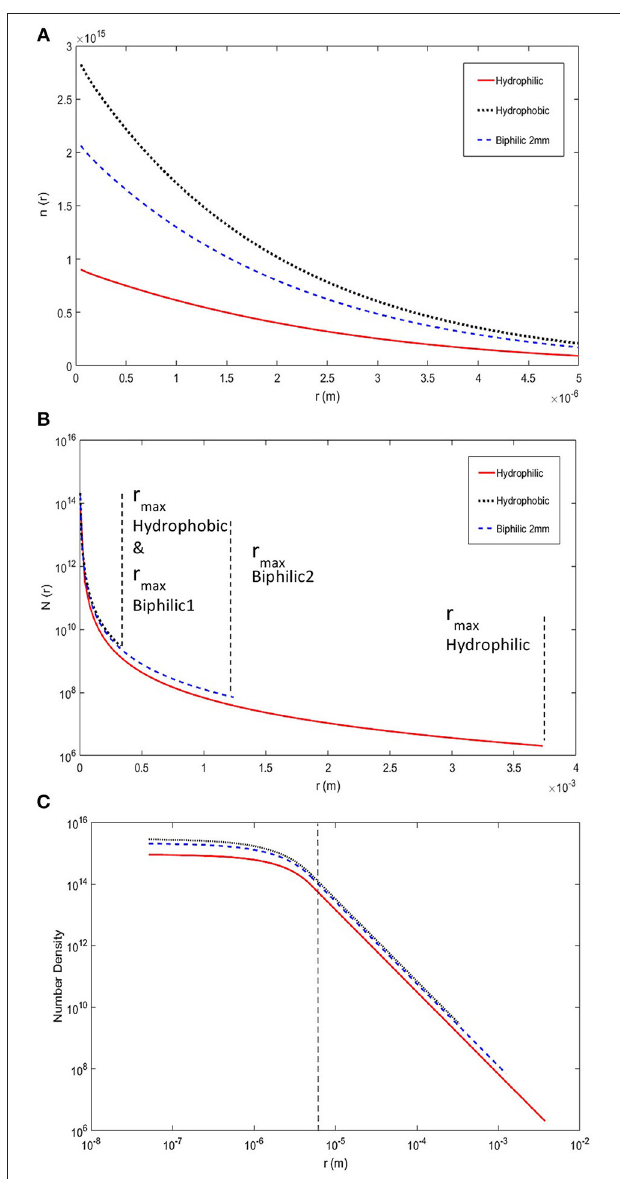
FIGURE 3 | Droplet size distribution as a function of droplet radius for hydrophilic, hydrophobic, and 2mm biphilic substrates. (A) The number densities are shown for small droplets formed by direct condensation. (B) The number densities are shown for large droplets formed by coalescence. The fall-off radii are shown for each substrate. The biphilic surface has two separate fall-off radii corresponding to the hydrophobic sites and hydrophilic base marked as biphilic1 and biphilic2, respectively. (C) The log-log graph of combined number densities for all droplets from initial nucleation to fall-off. The dashed line shows the borderline between small droplets and large droplets. The associated model parameters are: T sat 20 ◦ C, T w 10 ◦ C, δ coat = = − = 1 µ m, k coat 0.15 W/m.K, γ 2mm, hydrophobic θ a and θ r are 150 ◦ and = = 144 ◦ , and hydrophilic θ a and θ r are 73 ◦ and 34 ◦